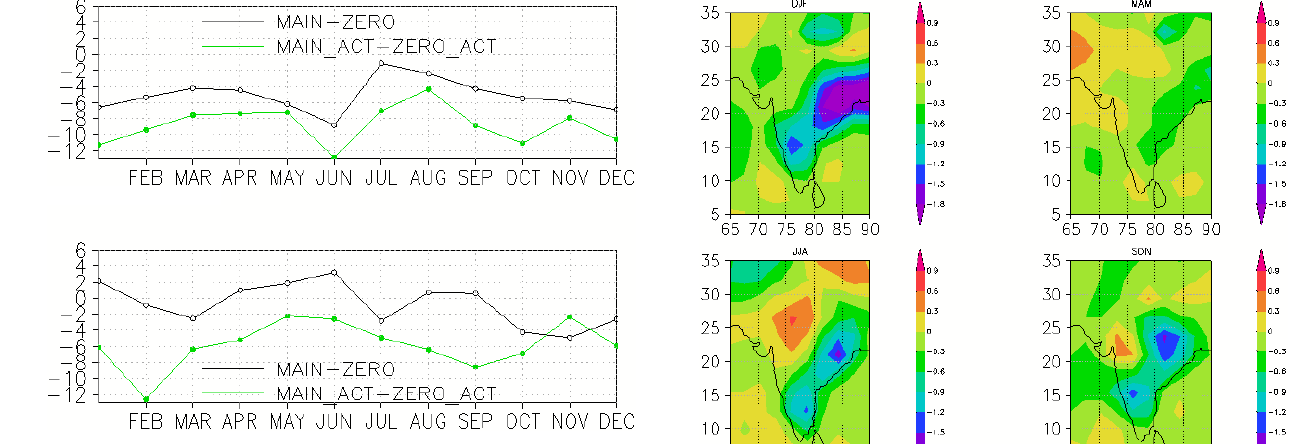
Figure 6. Seven-year monthly mean anthropogenic SW + LW ra- diation flux anomalies (in Wm − 2 ) in the area 65–90 ◦ E, 5–35 ◦ N in the MAIN and MAIN_ACT simulations with GAINS emissions (a) at the surface and (b) at the TOA (black: without, green: with aerosol–cloud activation).